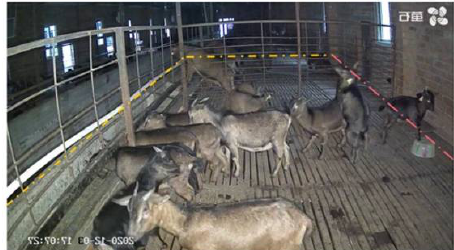
Figure 10. The diagram of counting area.